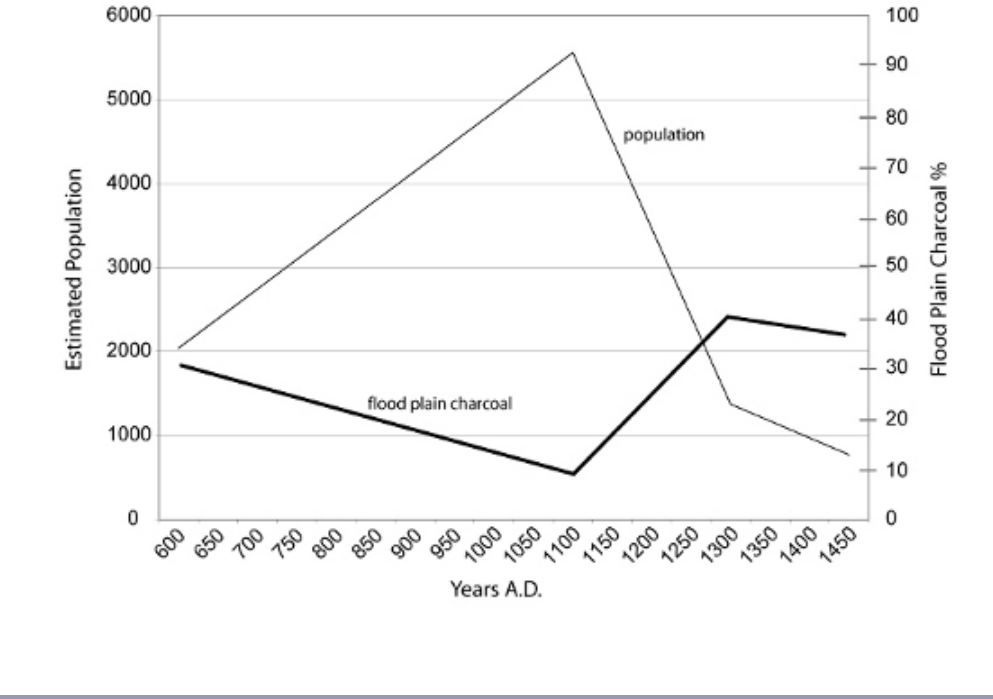
Fig. 4. Change over time in estimated population size and floodplain charcoal from village settlements in the Mimbres region. Population estimates for the Mimbres case are based on a large settlement database compiled as part of the Long Term Vulnerability and Transformation Project. The settlement database includes all sites in major full-coverage surveys across the region, as well as all known large sites (i.e., sites with approximately 30 rooms or more). The population estimates were produced by placing sites in each time period into a number of site size classes based on the best known and recorded components in the database for a particular time period. Sites for which less information was available were placed in size classes based on the available data and were assigned the mean room count of sites in that size class. Following Nelson and Schollmeyer (2003), each 2.5 rooms was assumed to represent one nuclear family household of approximately four individuals. Room-use life estimates were assumed to be roughly 50 years for the purposes of this analysis. The database is likely missing a large proportion of sites dating to the earliest time periods (Early and Late Pithouse periods: AD 400–1000). Thus, population estimates for the earliest periods were defined based on the rates of growth in the best-known portions of the region (Blake et al.